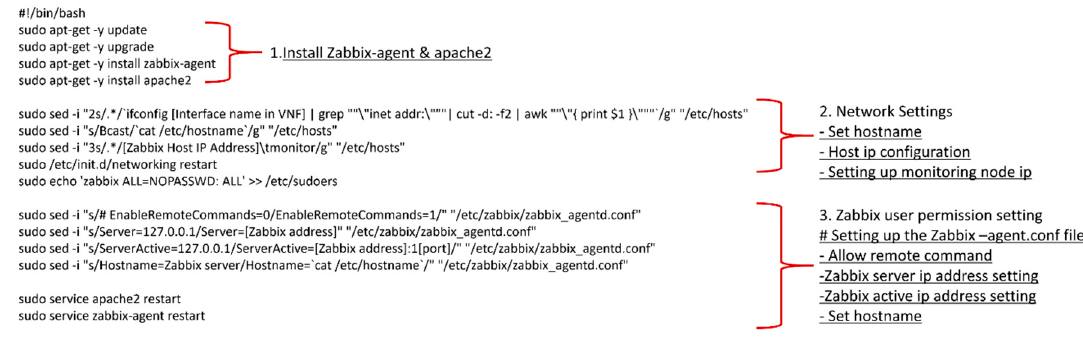
Figure 6. VNFD template for monitoring.